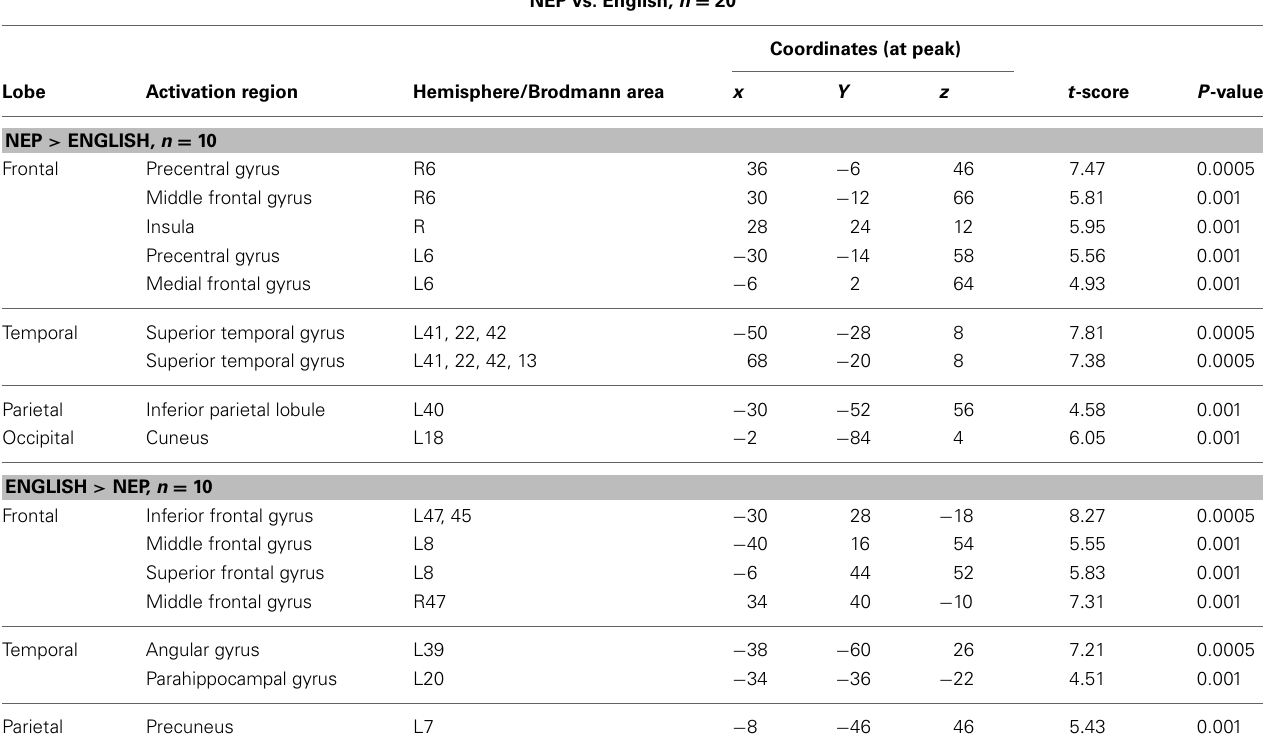
Table 4 | Univariate data: NEP and